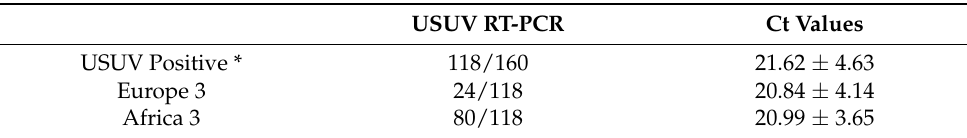
Table 1. Summary of virology data of the Eurasian